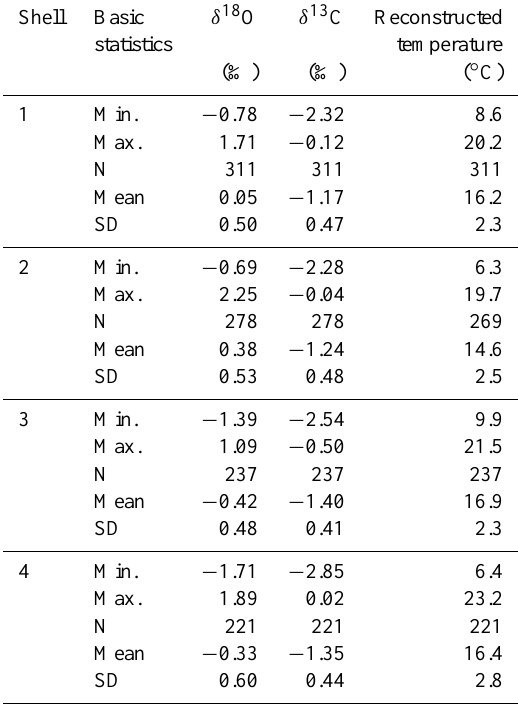
Table 1. Summary statistics of δ 18 O, δ 13 C and reconstructed tem- perature data retrieved from each E. directus